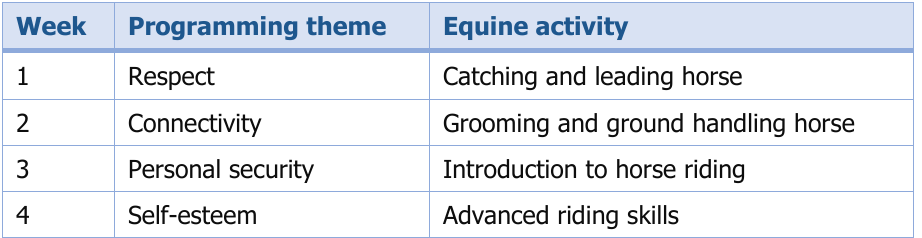
Table 1. Equine Assisted Learning 4-Week Program Themes and Activities for At- Risk